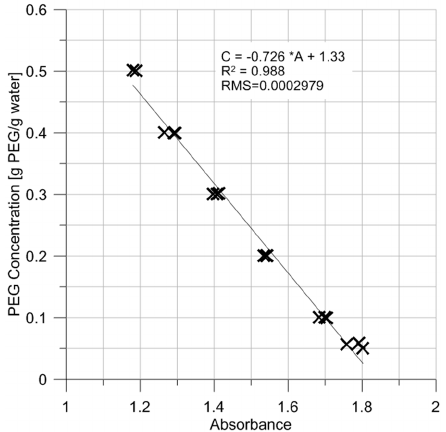
Figure 6. PEG concentration as a function of absorbance for all tests performed. All measurements were conducted at 20.5 ◦ C.